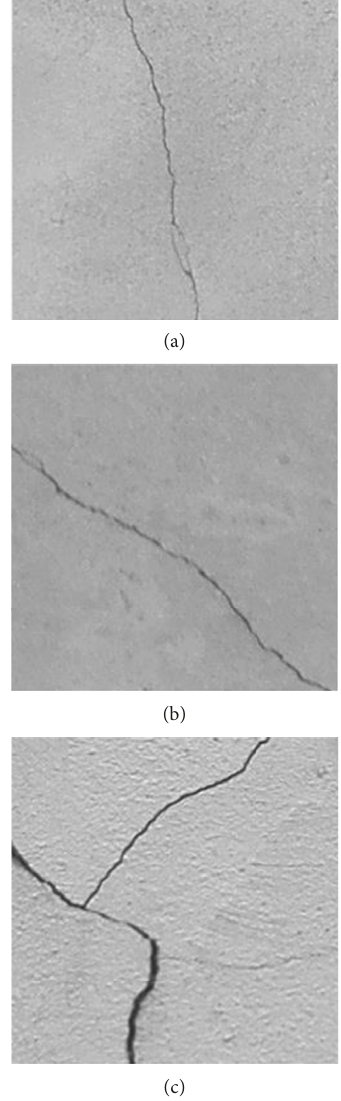
Figure 1: Concrete surface crack